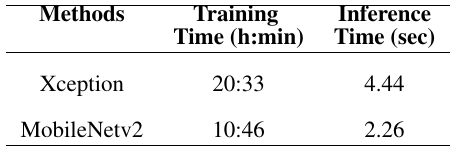
Table 1. Computational Complexity for the DeepLabv3+ Xception and MobileNetv2